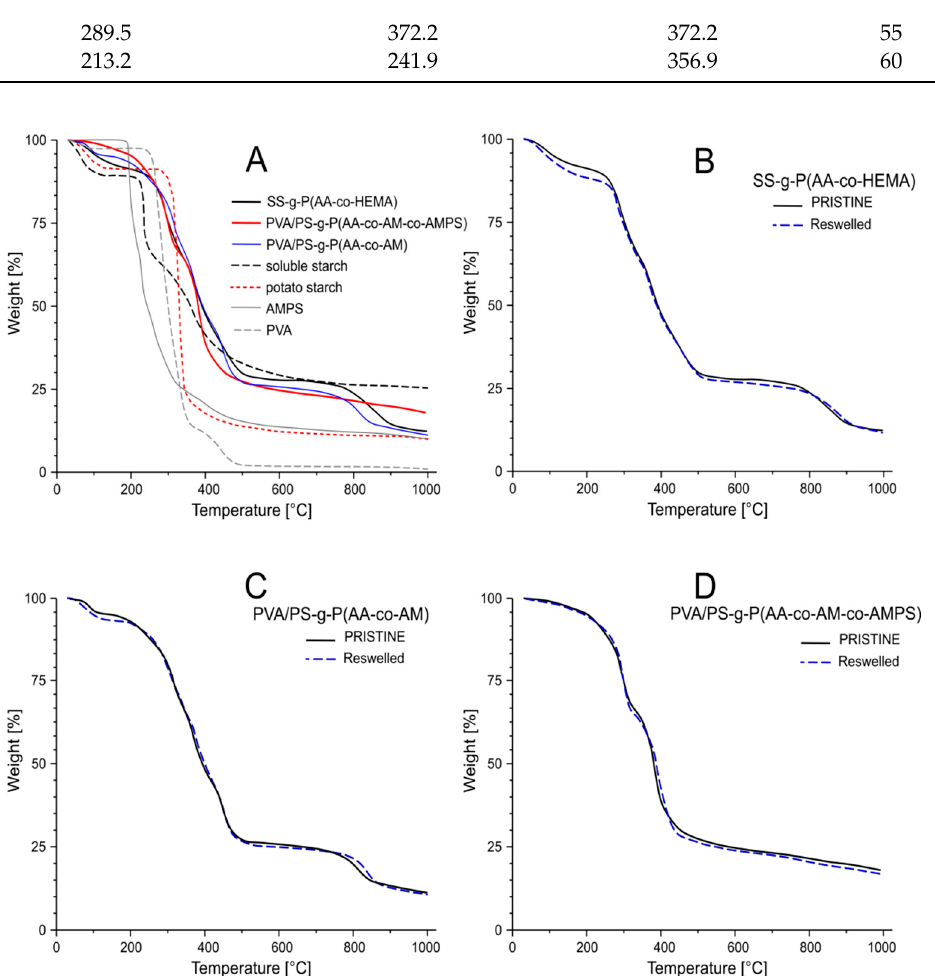
Figure 6. TG curves of studied substances superabsorbent polymers SS-g-P(AA-co-HEMA), PVA/PS-g-P(AA-co-AM-co-AMPS), PVA/PS-g-P(AA-co-AM) and selected starting compounds soluble starch, potato starch, AMPS and PVA ( A ). Comparison of polymer TG curves before swelling and after 10 swelling/drying cycles for SS-g-P(AA-co-HEMA) ( B ), PVA/PS-g-P(AA-co-AM) ( C ) and PVA/PS-g-P(AA-co-AM-co-AMPS) ( D ). The degradation of PVA/PS-g-P(AA-co-AM-co-AMPS) has five steps (Figure 6B and